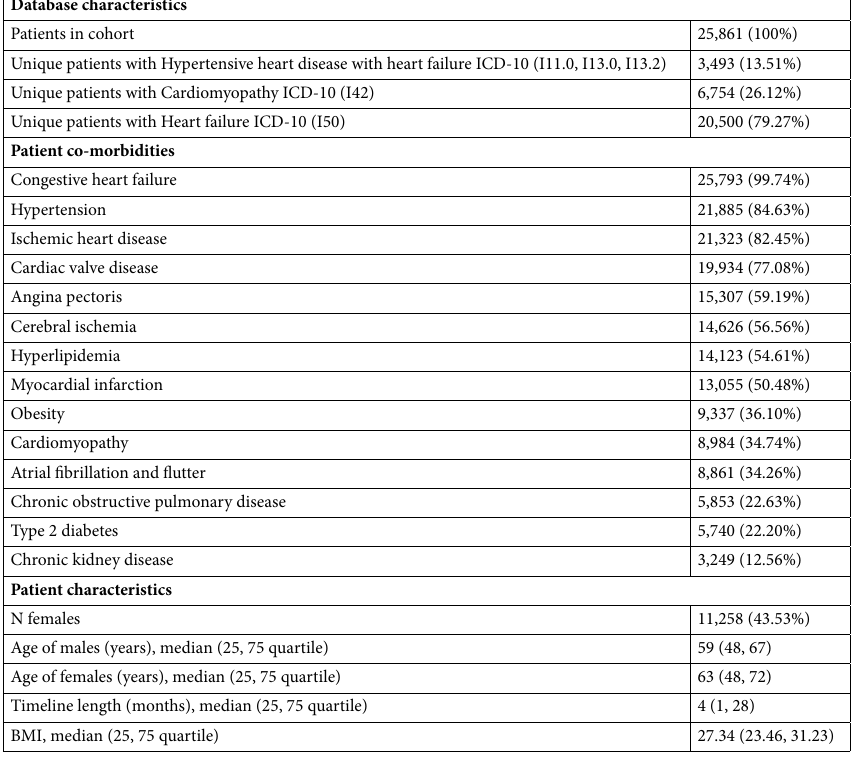
Table 1. Baseline characteristics of the heart failure